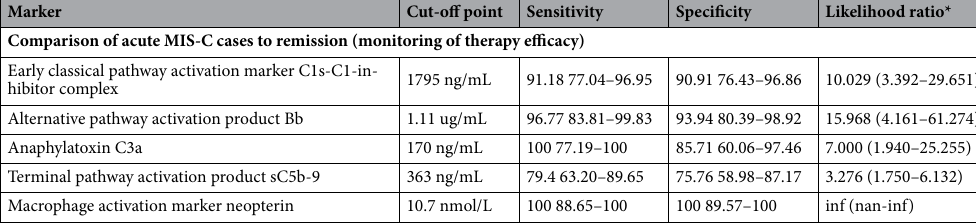
Table 1. Characteristics of selected biomarkers for therapy monitoring in MIS-C. *Likelihood ratio was calculated as sensitivity/(1-specificity), i.e. true positivity rate divided by the false positivity rate, indicating the diagnostic value of having a positive test result in supporting a certain condition (the remission of MIS-C). For calculation of likelihood ratio positive result was considered in the following way: laboratory parameters below the cut-off were regarded as positive, as these values are supposed to indicate remission, which is the condition in question. Confidence intervals were calculated according to the method described by Simel et al 44 . nan not a number (cannot be calculated); inf